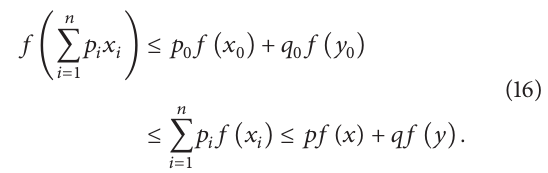
If 𝑐 is equal to some 𝑥 𝑖 = 𝑞 = 1/2 . Otherwise, it must be 𝑐 ∈ (𝑥 𝑝 0 0 pair, in which case we take 𝑥 0 = 𝑥 𝑖 and 𝑦 0 = 𝑥 𝑖+1 . Calculating 𝑞 𝑝 0 and 0 by (3), we also get It remains to apply Lemma 1 to both sides of the obtained equality in